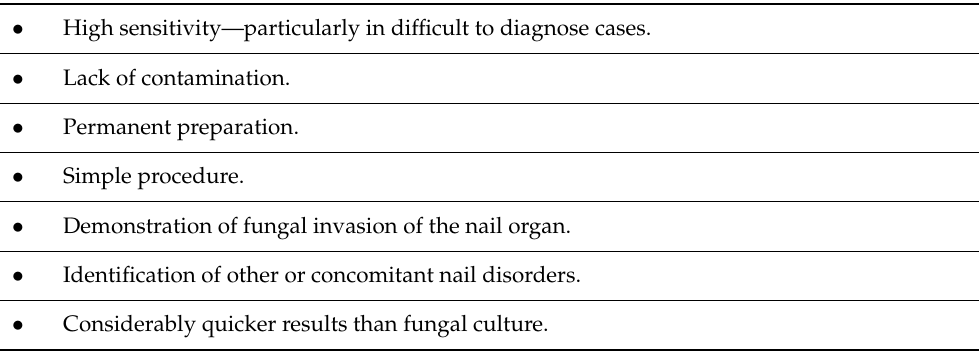
Table 2. Advantages of histopathology for the diagnosis of